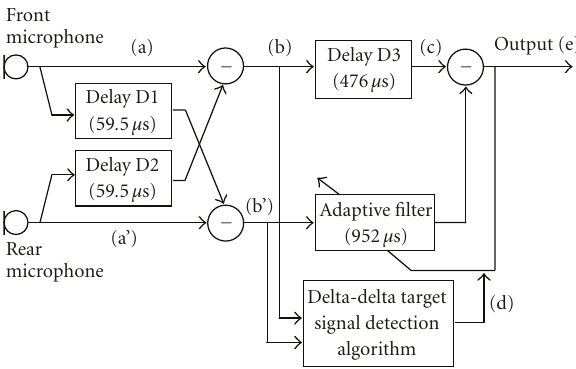
Figure 1: Block diagram of the beamforming algorithm implemented in the experimental real-time device. The two microphones are mounted in a behind-the-ear housing (intermicrophone distance 7mm).